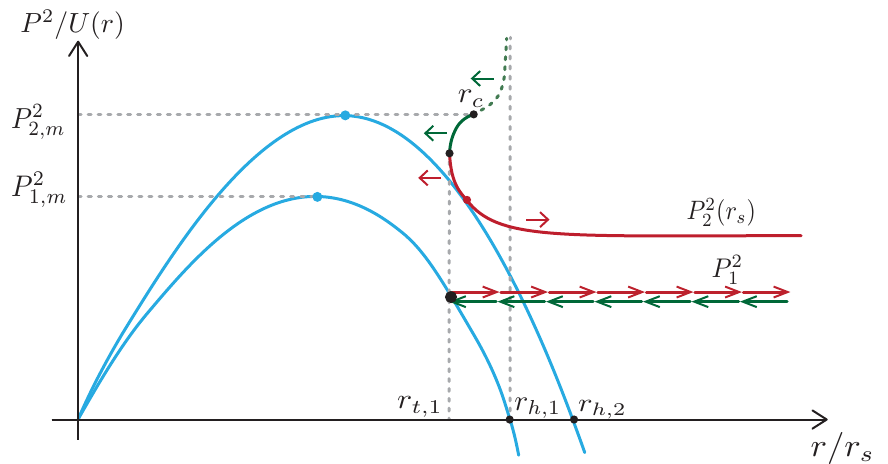
2 Figure 15. Illustration of the potentials U ( r s ; P 1 ) 1 ; 2 ( r ) (see eq. (4.8)), superimposed by a plot of P 2 (see eq. (4.11)) for a speci(cid:12)c value of P 2 . We have indicated by arrows the sign of _ r before hitting 1 the shell (on the P 2 lines) and right after hitting the shell (next to the P 2 ( r s ) lines). Red lines 1 2 are associated with surfaces that have a turning point in BH 1 and green lines with those that do not. The plot was made for P 1 > 0 but a similar plot can be made for P 1 < 0. The special point r c where P 2 becomes equal to the maximal value P 2 was very important in our analysis since in 2 ;m many of the cases studied (early shocks, symmetric boundary times) the solution for r s was found to be extremely close to it. The dashed part of the green curve P 2 ( r s ) is associated with surfaces 2 that will end on the singularity after crossing the shell and are therefore irrelevant for our